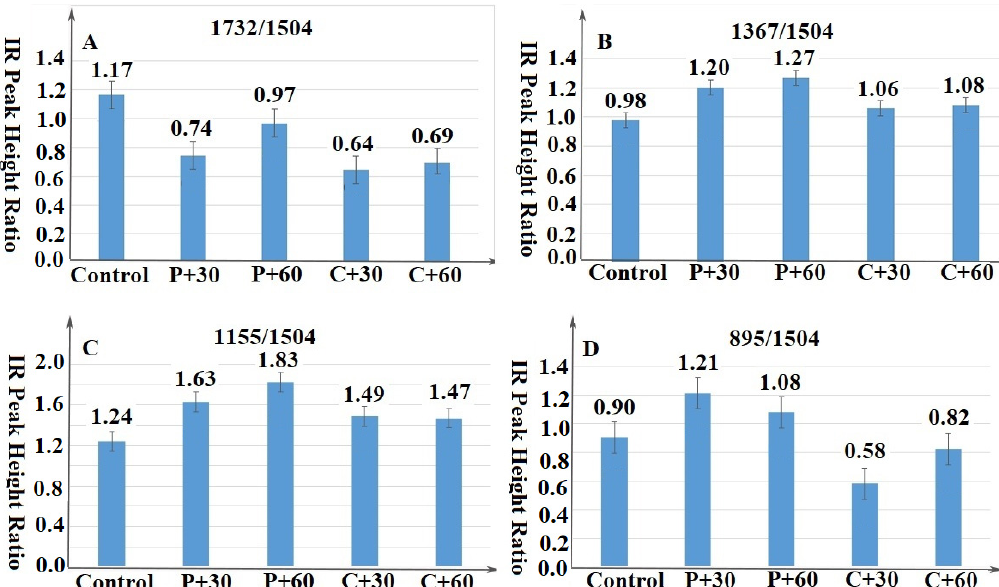
Figure 8. Effect of enzyme pretreatment on FT-IR spectra as shown by ratios between various carbohydrate fractions and lignin (( A ) for 1732/1504; ( B) for 1367/1504; ( C ) for 1155/1504 and ( D ) for 895/1504 respectively). Ratios between the xylans peak at 1732 cm − 1 and the lignin peak at 1504 cm − 1 were